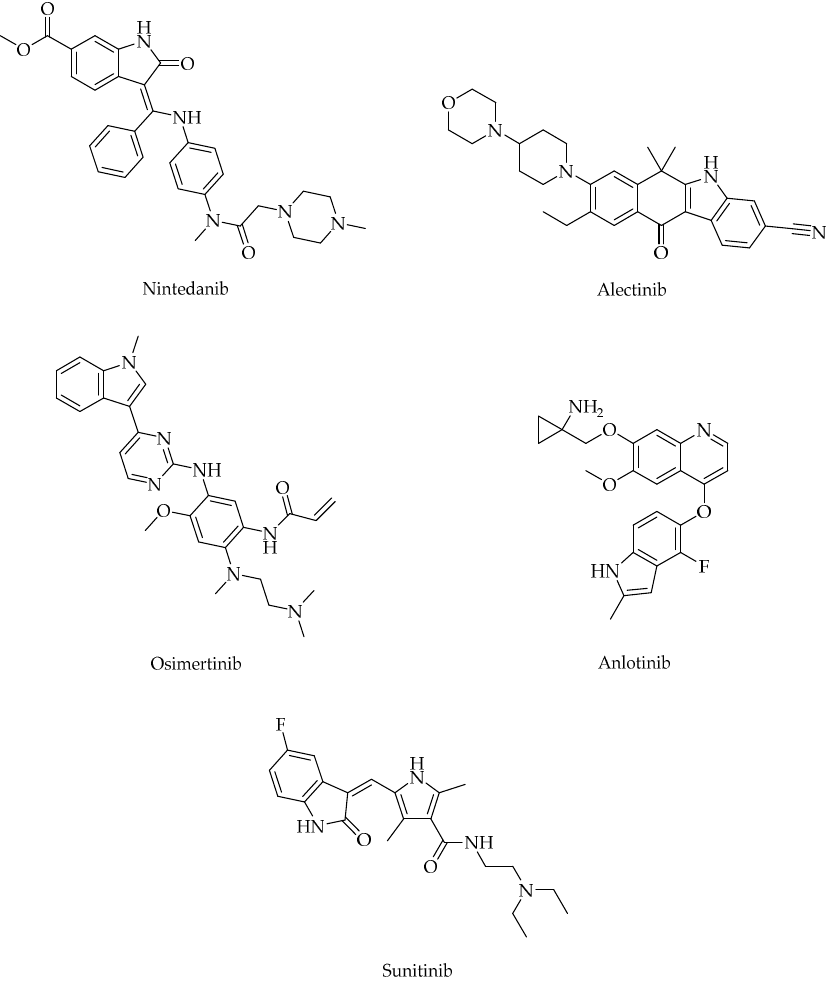
Figure 1. Indole-based anti-NSCLC agents.